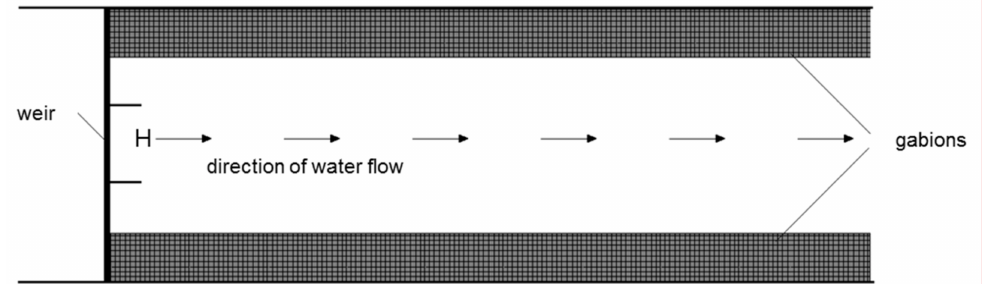
Figure 6. Longitudinal arrangement of a treatment system for hypolimnetic water using reactive materials. H: outlet of the hypolimnion withdrawal